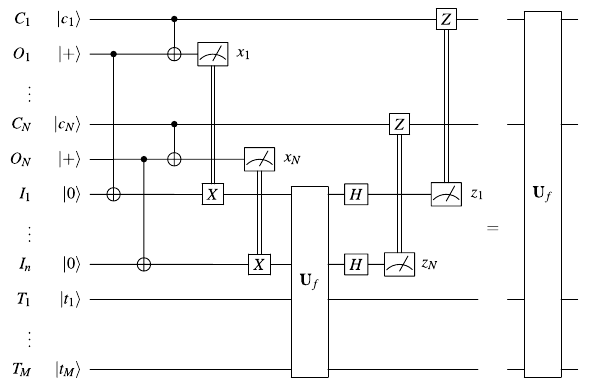
Figure 1. Multipartite distribution of N -qubit quantum functions 9 .